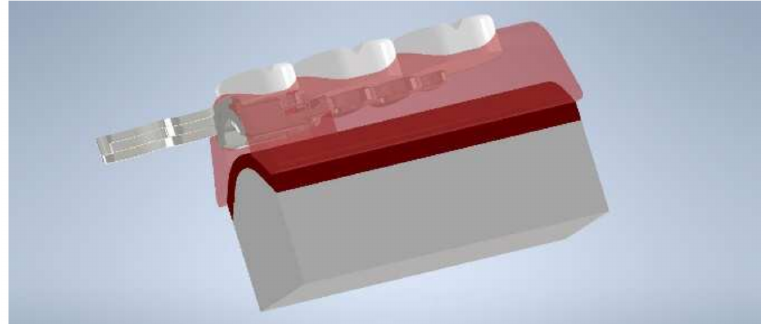
Figure 1. The 3D Model of the unilateral mandibular